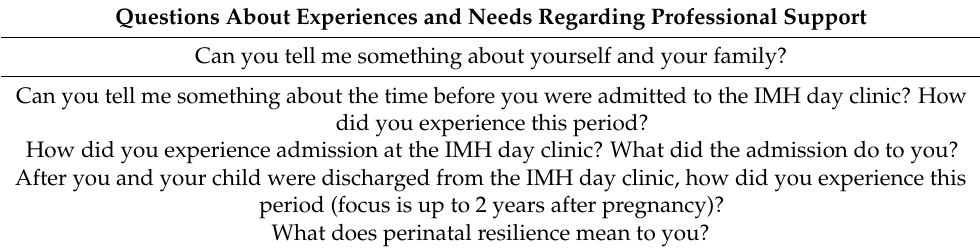
Table 1. A semi-structured interview guide, including icebreaker